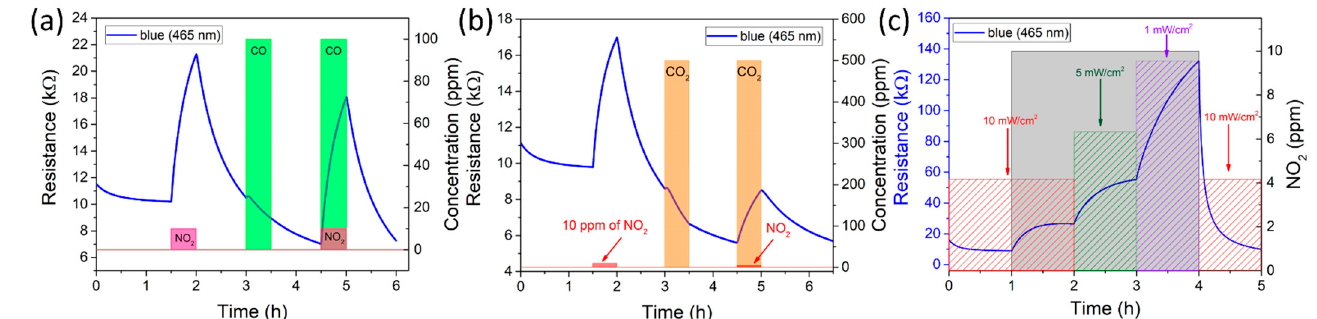
Figure 9. The response of cross-sensitivity by introducing a high concentration of interfering gas, ( a ) 100 ppm of CO and ( b ) 500 ppm of CO 2 , in order to investigate the selectivity of the sensors. ( c ) The response of the sensors with different intensities of the blue LED (i.e., 1, 5, and 10 mW/cm 2 ) to 10 ppm of NO 2 . Table 1. The performance comparison ZnO-based gas sensors decorated Au NPs with different operating conditions.